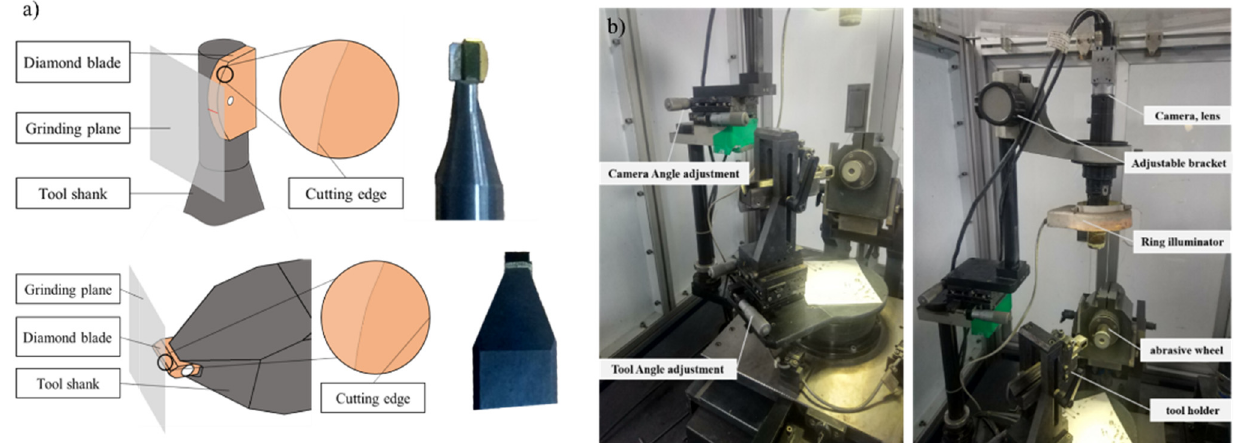
Figure 10. ( a ) Schematic diagram of diamond tool, ( b ) Visual inspection platform on diamond tool grinder.